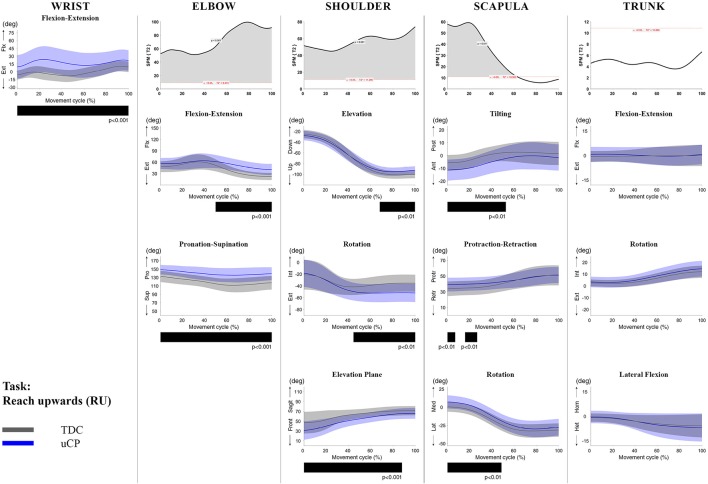
Comparison between children with uCP and TDC during the RU task for all joint angles. Each column corresponds to a joint (from left to right: wrist, elbow, shoulder, scapula, and trunk). The top image of each column is the SPM output of the vector field analysis (Hoteling's test, except for the wrist, where a t-test was computed). Below, mean (bold line) and standard deviation (translucent area) of the TDC (gray) and uCP (blue) of each vector component, and the respective post-hoc SPM{t} output. The black bar under each kinematic profile indicates clusters of significant difference between groups.